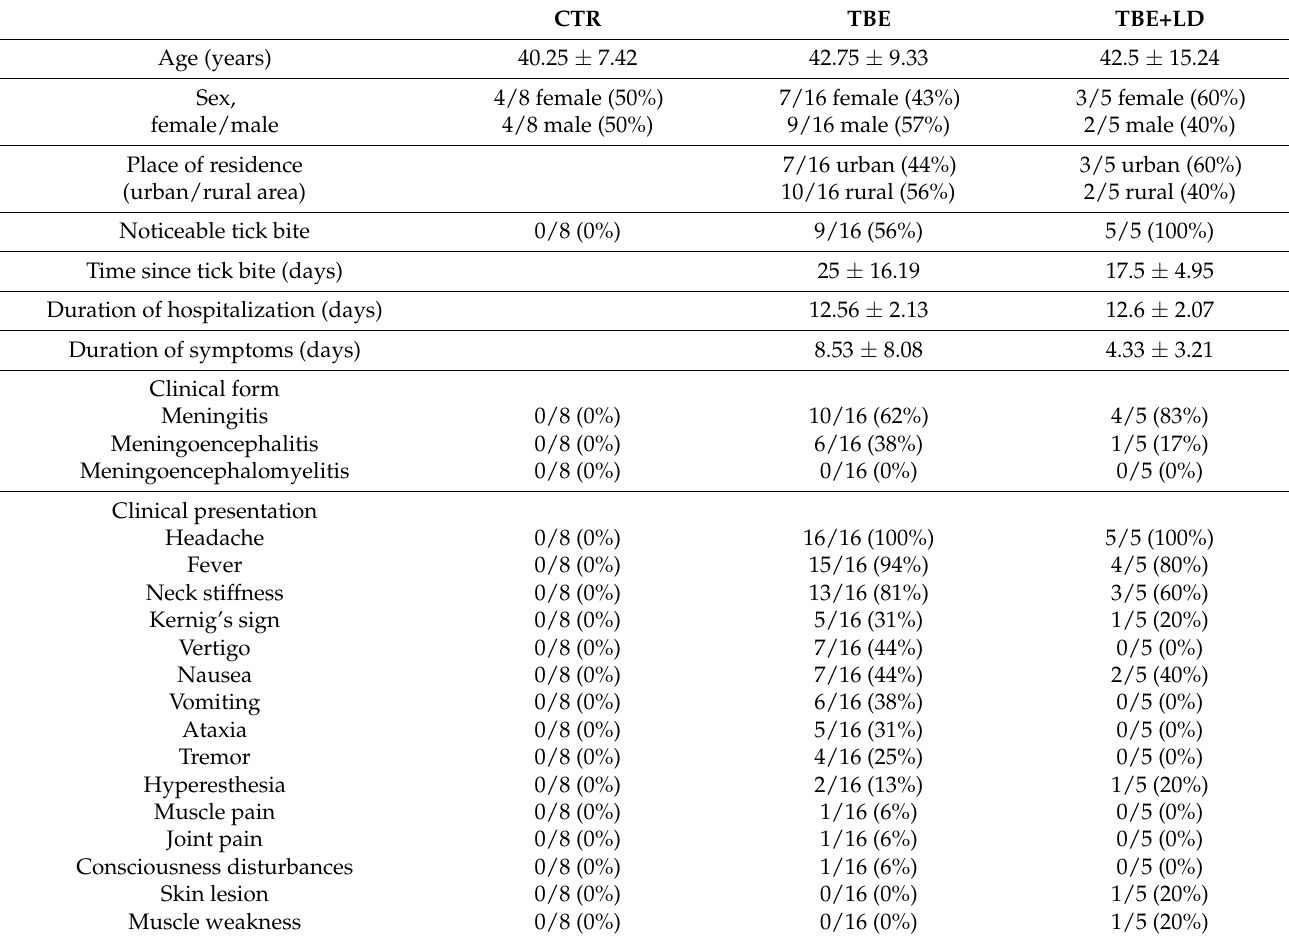
Table 1. Demographic and clinical characteristics of TBE and TBE co-infected (TBE+LD) patients compared to healthy subjects (CTR,